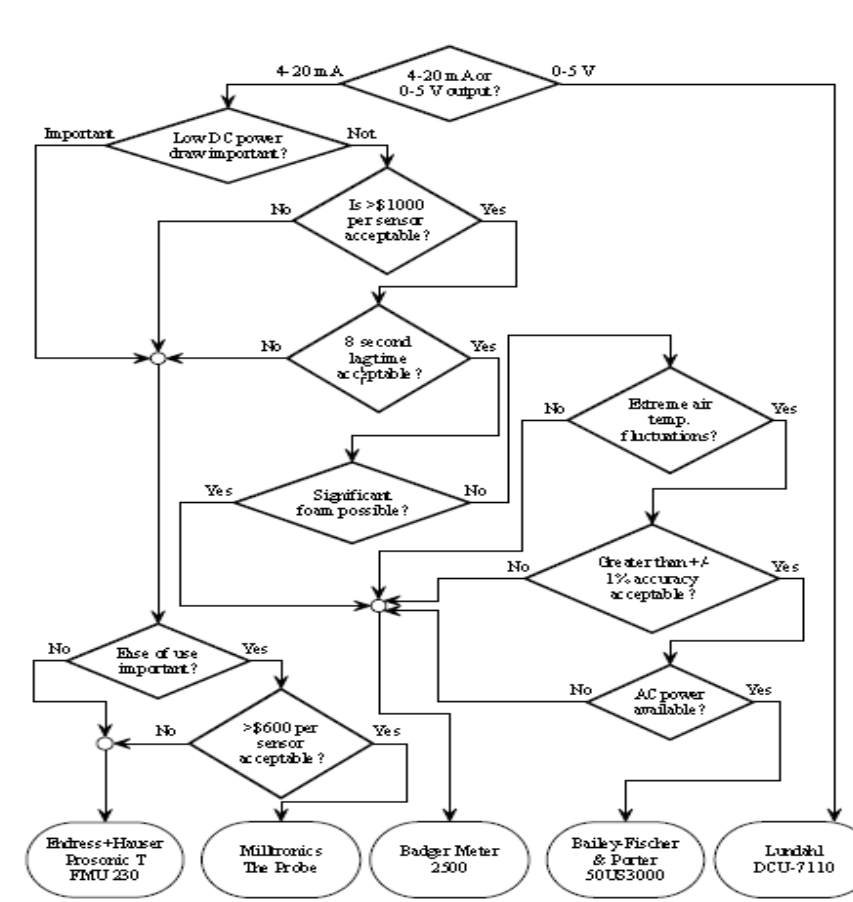
Figure 2: Flowchart for selecting an ultrasonic sensor for a specific selection.